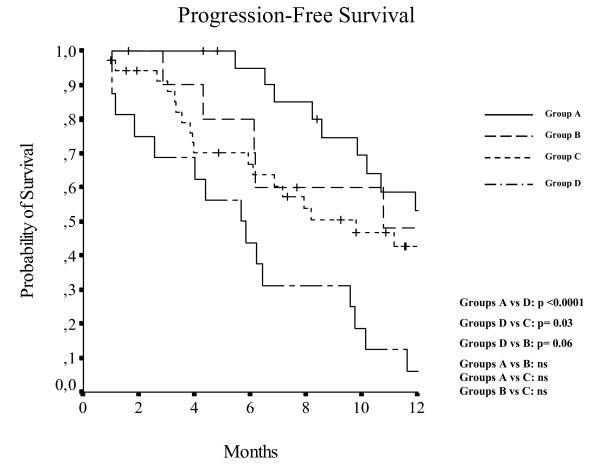
PFS in four group of patients. For corresponding lines see the key in figure 1. Group A: +GCN/1st line; Group B: -GCN/1st line; Group C: +GCN/more lines; Group D: - GCN/more lines; (+: increased; -: non-increased; GCN: EGFR Gene Copy Number) P value adj: Groups A vs D: p < 0.0001; Groups D vs C: p = 0.03; Groups D vs B: p = 0.06; Groups A vs B: ns; Groups A vs C: ns; Groups B vs C: ns.